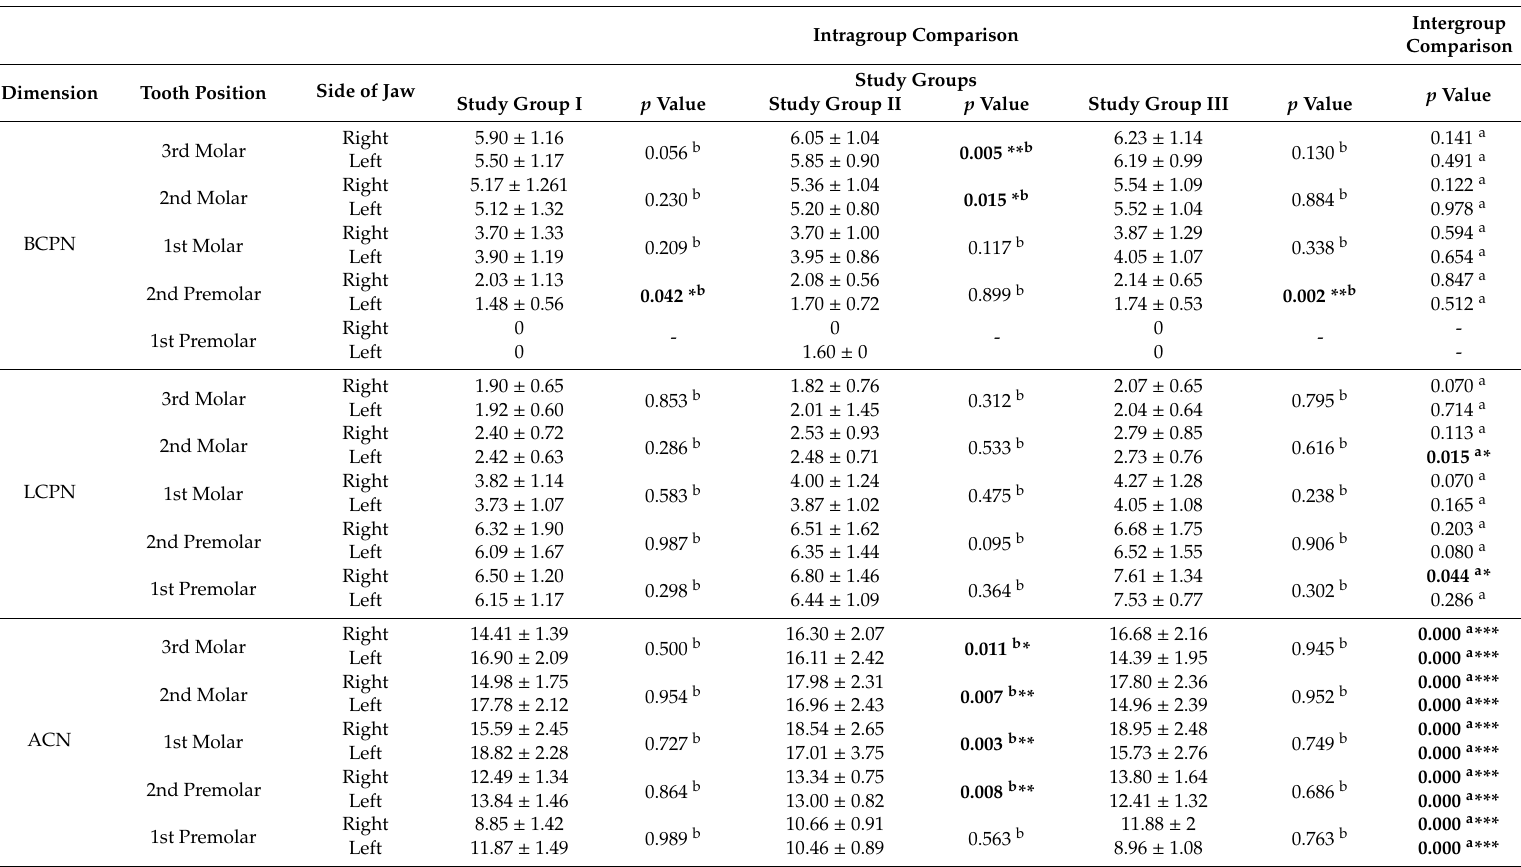
Table 2. BCPN, LCPN and ACN dimensions of right and left side of jaws measured in millimeters (mm) and presented as mean ±